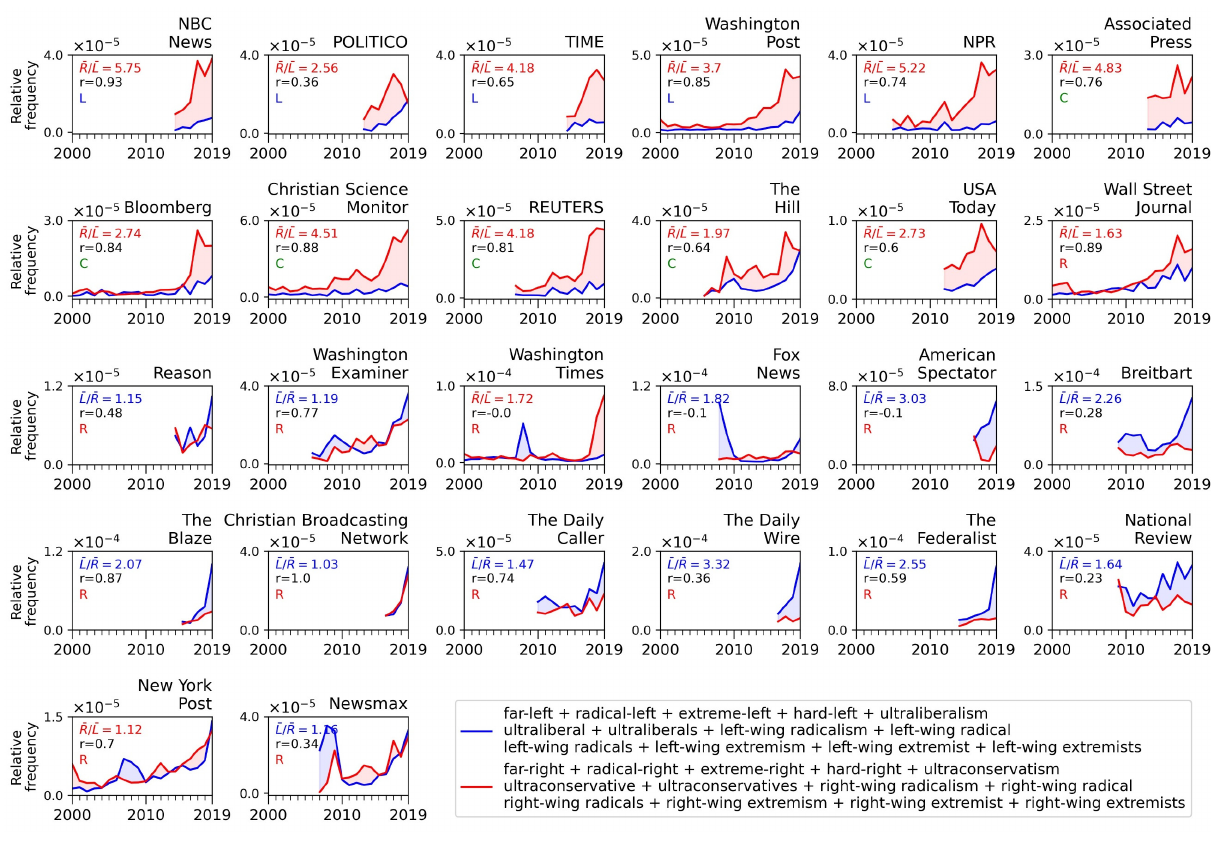
Figure 4. Yearly prevalence of an aggregate set of terms denoting far-right (red line) and far-left (blue line) political extremism in popular U.S. news media outlets. The colored area between time series for each outlet is used to highlight the dominant prevalence. Red areas indicate higher average prevalence of far-right denoting terms. Conversely, blue areas indicate higher prevalence of far-left denoting terms. The average prevalence ratio between both time series ( 𝑅(cid:3364) / 𝐿(cid:3364) or 𝐿(cid:3364)/𝑅(cid:3364) ) is also color-coded according to which ratio is dominant. The Pearson correlation coefficient, r, between the time series is shown on the top left of each subplot. The political bias from each outlet, according to the AllSides Media Bias Chart 2019 v1.1 (AllSides 2019), is indicated with L (left-leaning), C (center-leaning) and R (right-leaning).